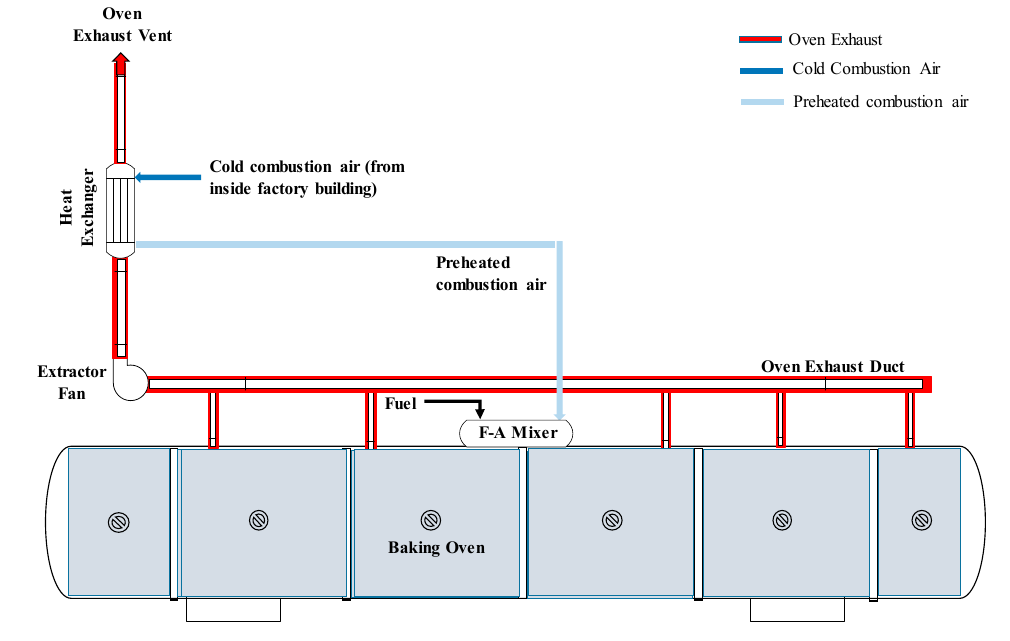
Figure 3. Schematic of combustion air preheating process using oven exhaust.